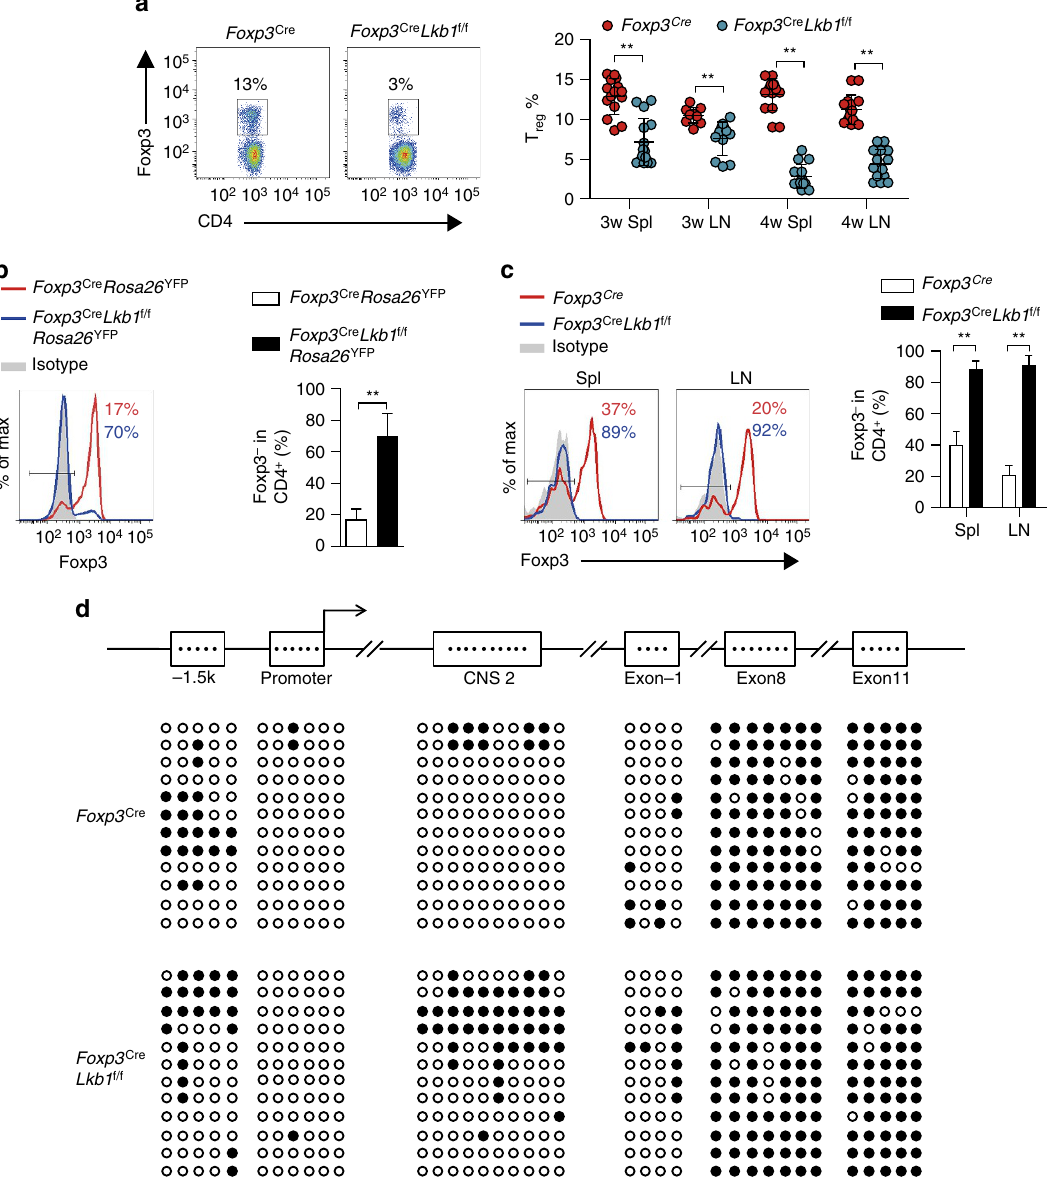
Figure 3 | Lkb1 stabilizes Foxp3 expression and prevents CNS2 methylation. ( a ) Foxp3 þ cell percentages among CD4 þ T cells in spleen and lymph nodes from Foxp3 Cre and Foxp3 Cre Lkb1 f/f mice of different ages ( n ¼ 10–15). ( b ) Foxp3 expression in CD4 þ Rosa26 -YFP high ( Rosa26 -YFP labelled the cells that have experienced the expression of Foxp3, Rosa26 -YFP was much brighter than and thus distinguishable from Foxp3-YFP) cells from Foxp3 Cre Rosa26 YFP and Foxp3 Cre Lkb1 f/f Rosa26 YFP mice. ( c ) Foxp3 expression in T reg cells doubly sorted from Foxp3 Cre and Foxp3 Cre Lkb1 f/f mice and transferred together with T n cells into Rag1 (cid:2) / (cid:2) mice for 3 weeks ( n ¼ 3). ( d ) Methylation of the CpG motifs of the (cid:2) 1.5kb region, promoter, CNS2, exon 1, exon 8 and exon 11 across the Foxp3 locus in T reg cells from Foxp3 Cre and Foxp3 Cre Lkb1 f/f mice, determined by bisulfite sequencing. Filled circles represent methylated CpG sites and open circles represent unmethylated CpG sites. Two-way analysis of variance (ANOVA) was used for statistical analyses in a,c , and unpaired two-tailed Student’s t -test was used for statistical analyses in b (** P o 0.01); error bars represent s.d.; all data are representative of at least two independent